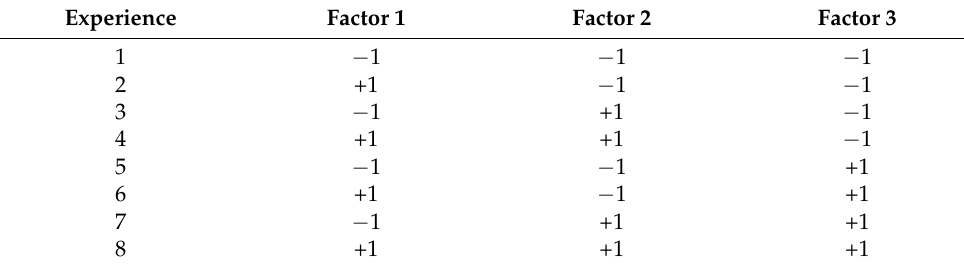
Table 2. Application of factorial design (Three factors).